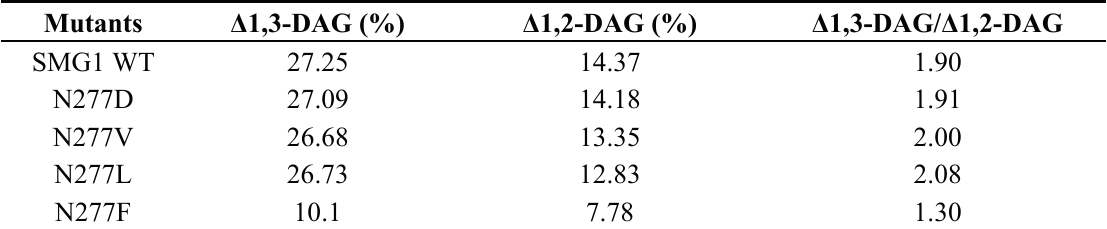
Table 2. The ratio of decreased amount of 1,2-DAG and 1,3-DAG in the hydrolysis